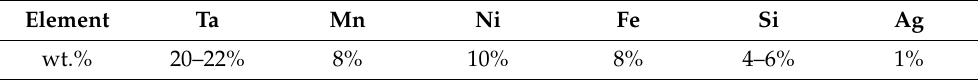
Table 2. The concentration of the main element compositions in the EcSETCs